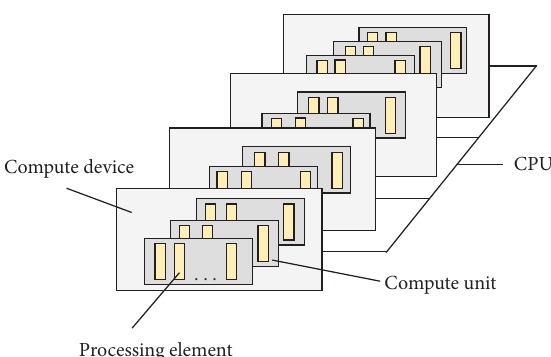
Figure 2: View of the hardware platform by OpenCL.